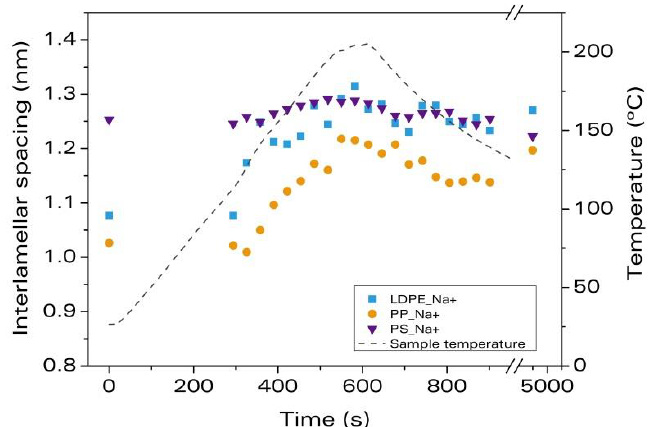
Figure 4. Evolution of the interlamellar spacing of the clay platelets during foaming for the materials with nanoclay, Na + .